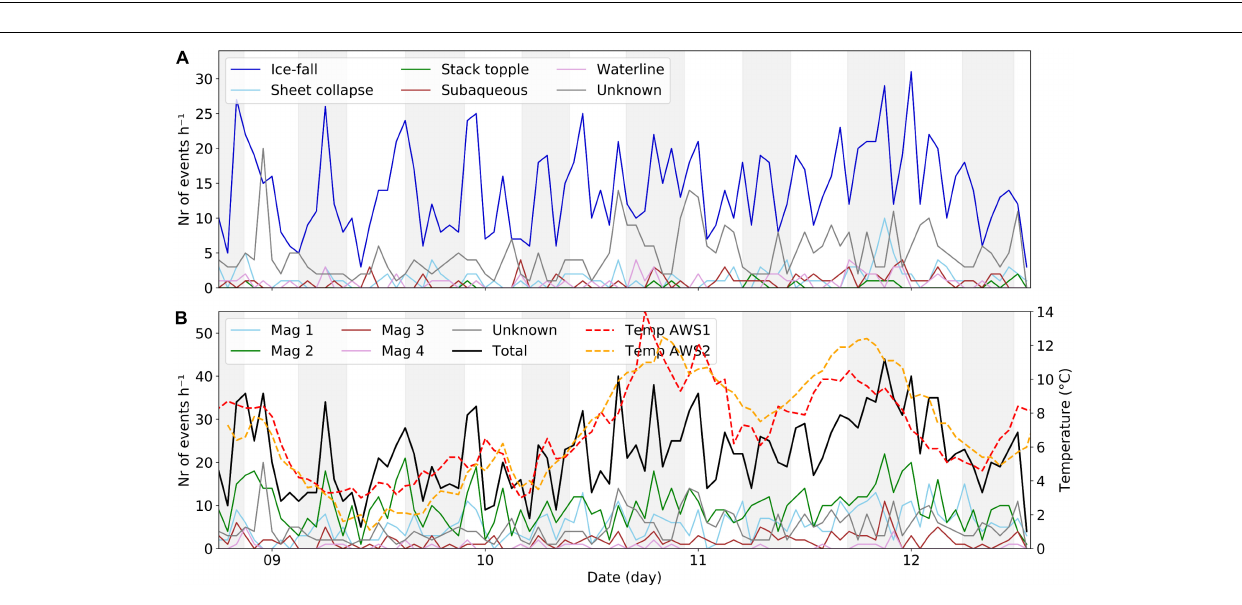
FIGURE 6 | Calving event rates detected in the sTLC images over a 4 day period in July 2018. (A) Number of events per hour for the different calving types. (B) Number of events per hour for the different calving magnitudes. Air temperature from AWS1 and AWS2 is shown on the right axis. The gray background shading indicates rising